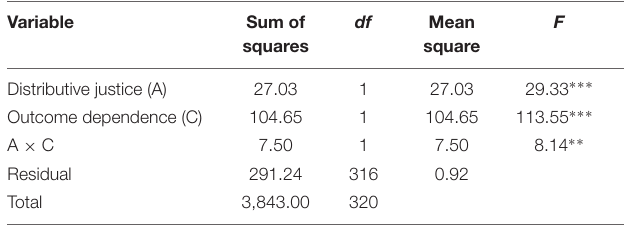
TABLE 3 | ANOVA of the effects of distributive justice, outcome dependence, and their interaction on public cooperation intention. Variable Sum of df squares